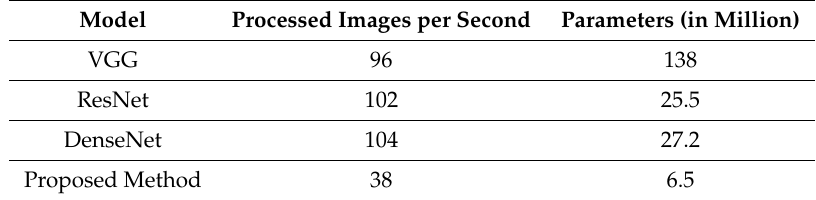
Figure 8. The inference time per image is estimated for the same batch size of 8 for all methods. Table 5. Network complexities with the parameters.